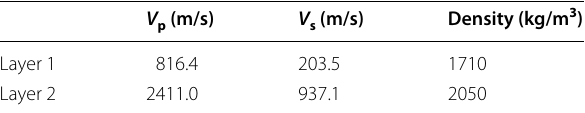
Table 1 Velocity model used for 1-D analytical